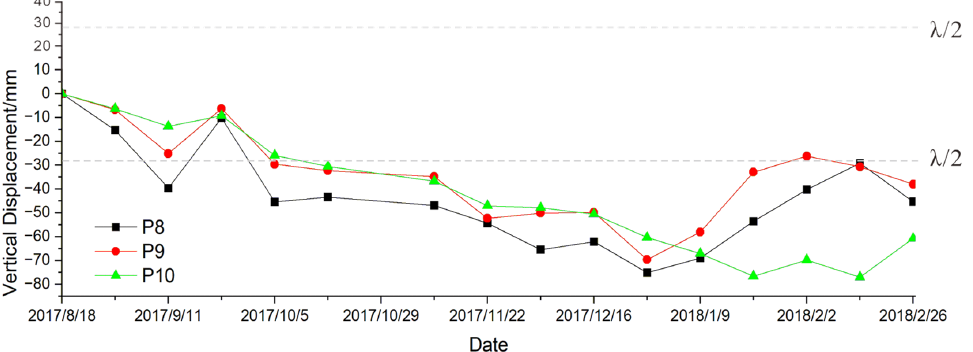
Figure 18. Time series deformation diagram of sampling points in region 3. The gray dotted lines are ambiguity (wavelength/2).